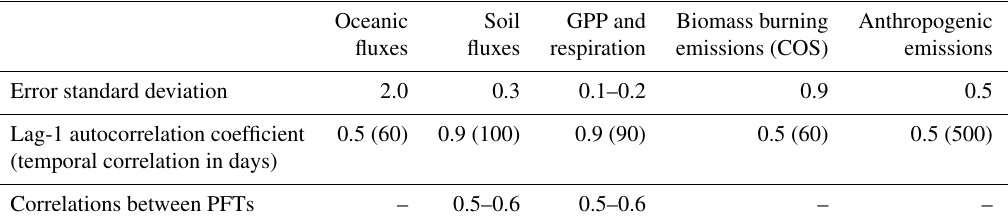
Table 3. Description of the prior error covariance matrix. Since the control vector is made of low-resolution multipliers to reference maps, the standard deviations are fractions of the reference values. The lag-1 autocorrelation coefficients are the correlations assigned between two consecutive time steps for each controlled variable, the time step being defined in Table